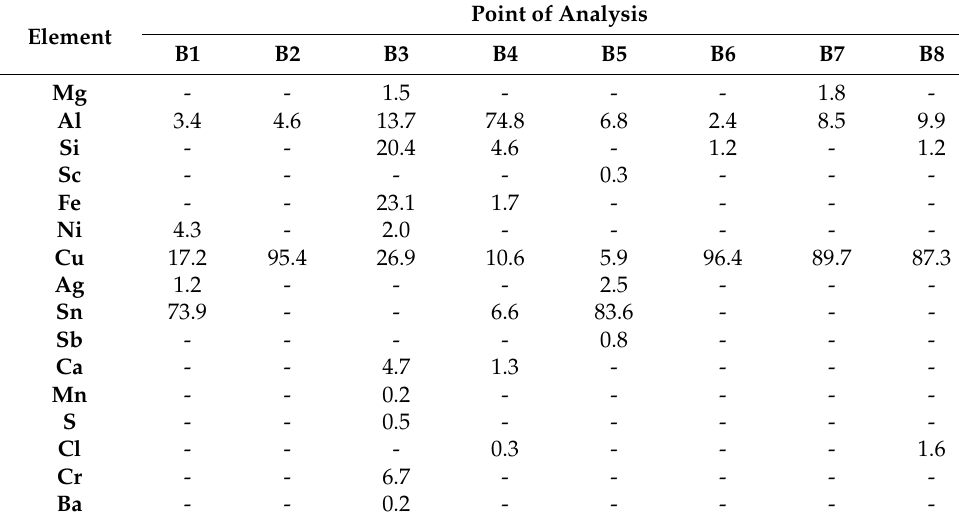
Table 5. Elemental concentrations [% at.] measured with EDS in the micro-areas marked in Figure 6.